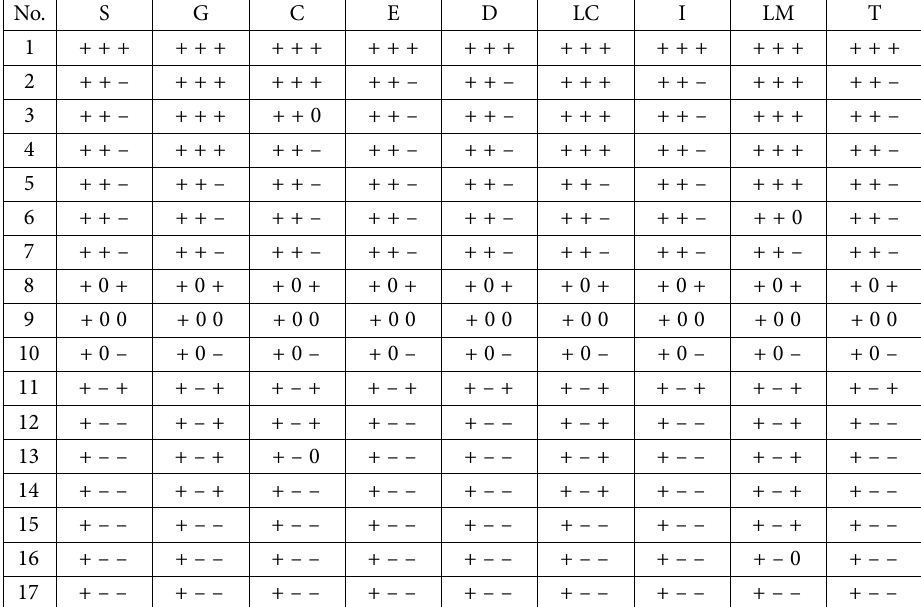
Table 6. Research results – set of scenarios (source: elaborated by the authors)